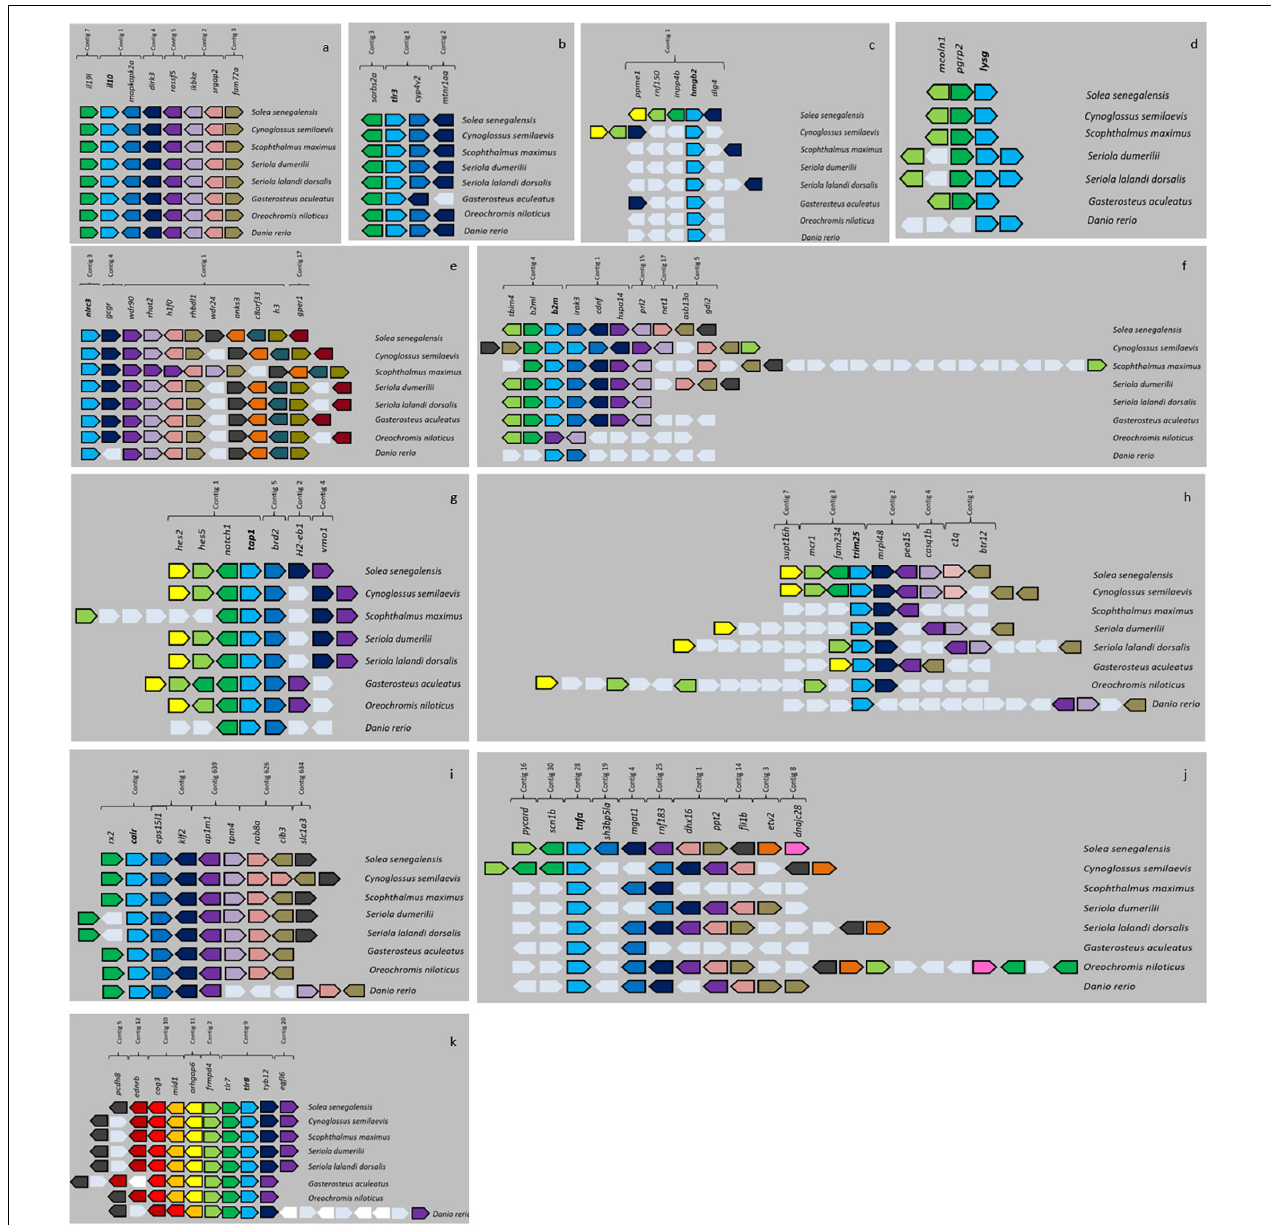
FIGURE 5 | Micro-synteny of 11 BAC clones. Genes of the species C. semilaevis , S. maximus, S. lalandi dorsalis, S. dumerili, G. aculeatus, O. niloticus, and D. rerio are represented in different colors. White color indicates non-synteny genes. (a) BAC clone il10 ; (b) BAC clone tlr3 ; (c) BAC clone hmgb2 ; (d) BAC clone lysg ; (e) BAC clone nlrc3 ; (f) BAC clone b2m ; (g) BAC clone tap1 ; (h) BAC clone trim25 ; (i) BAC clone calr ; (j) BAC clone tnf alfa ; (k) BAC clone